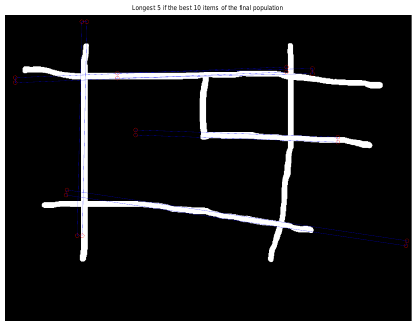
Figure 10. Synthetic segmentation image processed by DE algorithm (longest 5 of the 10 best